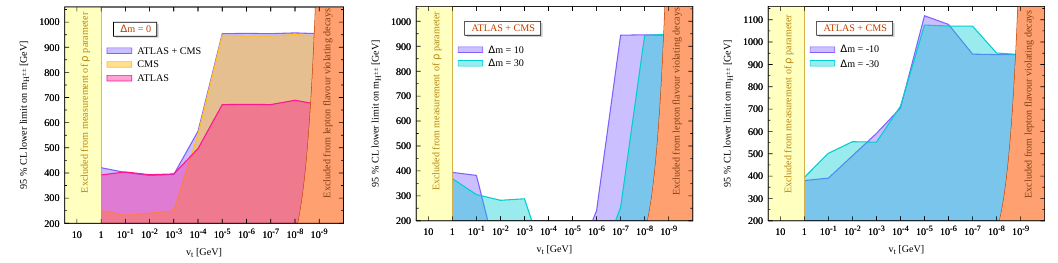
Figure 4 . Left: 95% CL lower limits on m as a function of v t for ∆ m = 0 assuming NH H ±± with m 1 = 0 . 03 eV. The shaded regions are excluded from different searches at the 13 TeV LHC. Middle(Right): excluded regions from the CMS and ATLAS combined search for ∆ m = 10 and 30 ( − 10 and − 30 )